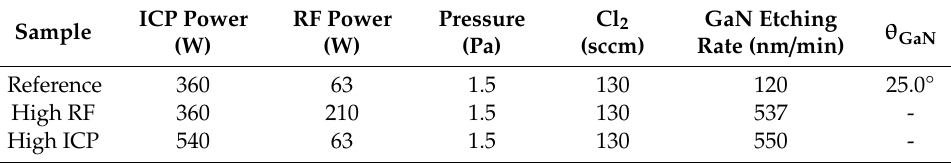
Table 1. Result of PR-masked GaN samples under di ff erent etching